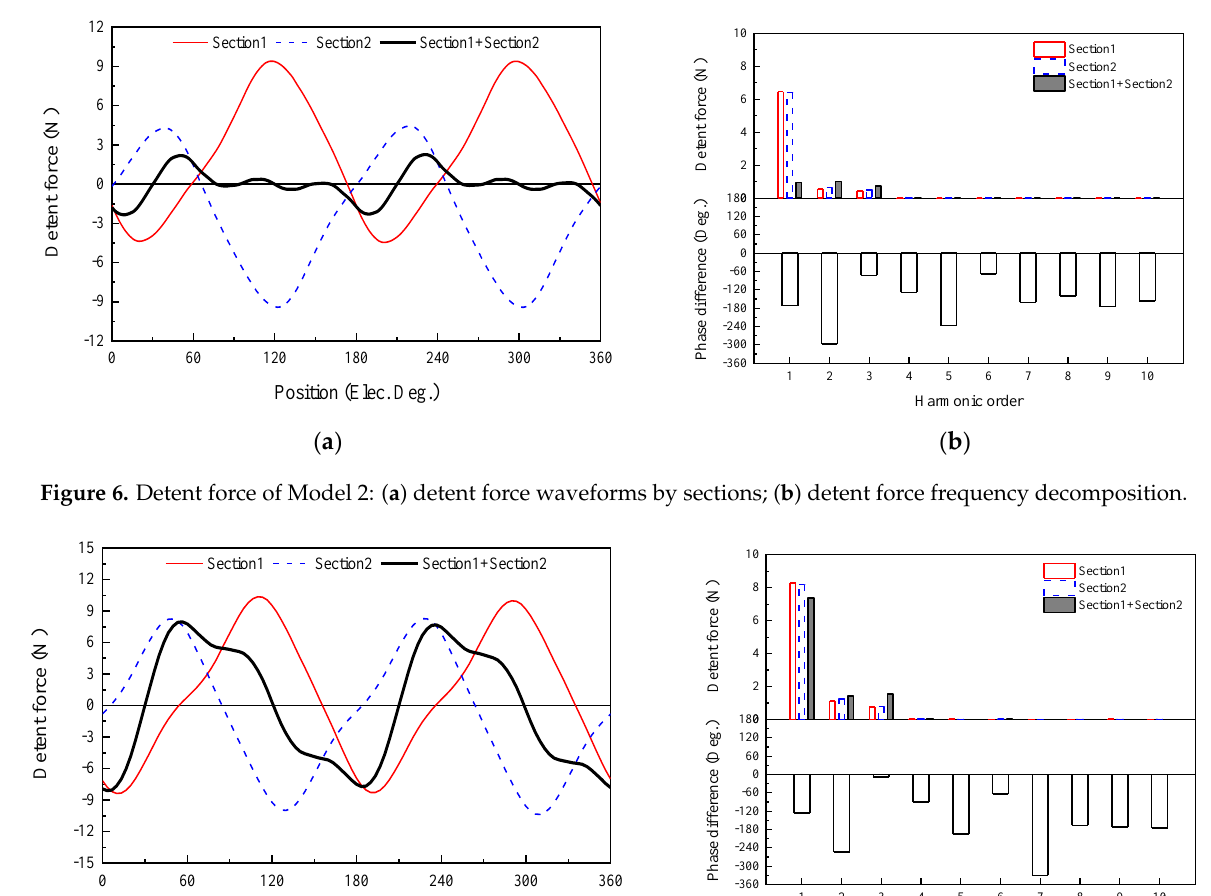
Figure 5. Detent force of Model 1: ( a ) detent force waveforms by sections; ( b ) detent force frequency decomposition.